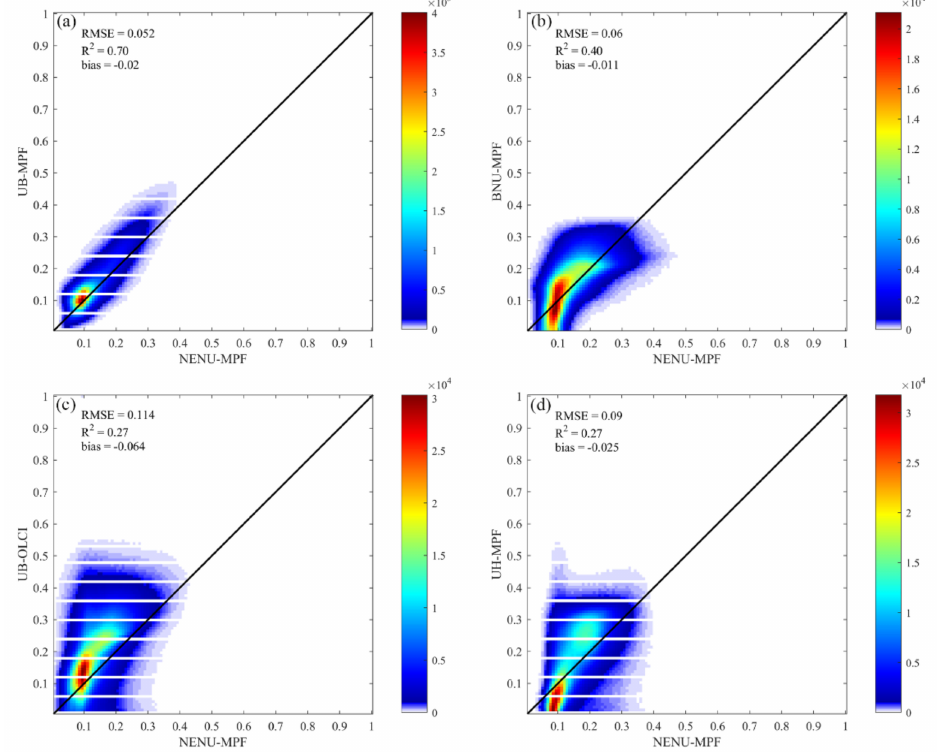
Figure 15. Comparison of NENU-MPF dataset with the ( a ) UB-MPF, ( b ) BNU-MPF, ( c ) UB-OLCI, and ( d ) UH-MPF datasets. The color gradient represents the density of the scatter in each grid. While the consistencies between the NENU-MPF and UB-OLCI datasets (R 2 = 0.27, RMSE = 0.114, and bias = − 0.064) and the NENU-MPF and UH-MPF datasets (R 2 = 0.27, RMSE = 0.09, and bias = − 0.025) are relatively poor. The discrepancies between the